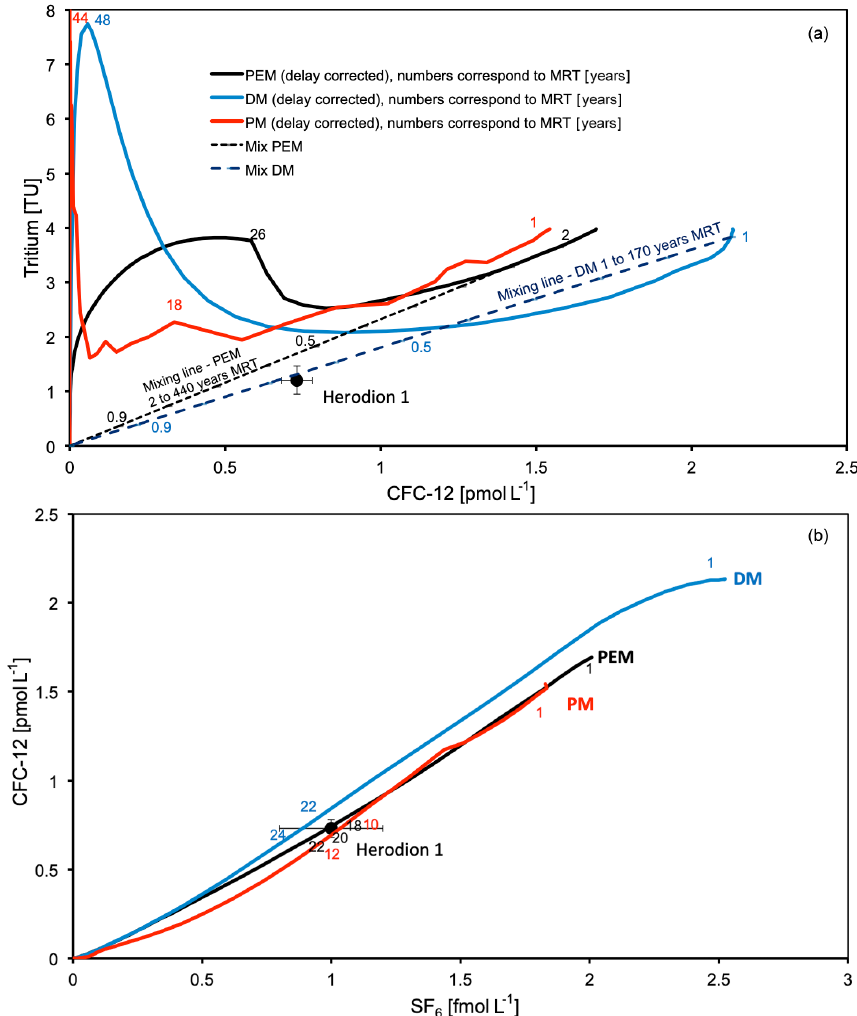
Figure 6. Modelling results for groundwater from the Herodion 1 well, applying PM (red), PEM (black) and DM (blue) and (a) tritium vs. CFC-12 and (b) CFC-12 vs. SF 6 . The calculated delays of CFC-12 are 30, 20, and 28 years according to the models PM, DM and PEM, respectively (ref. Table